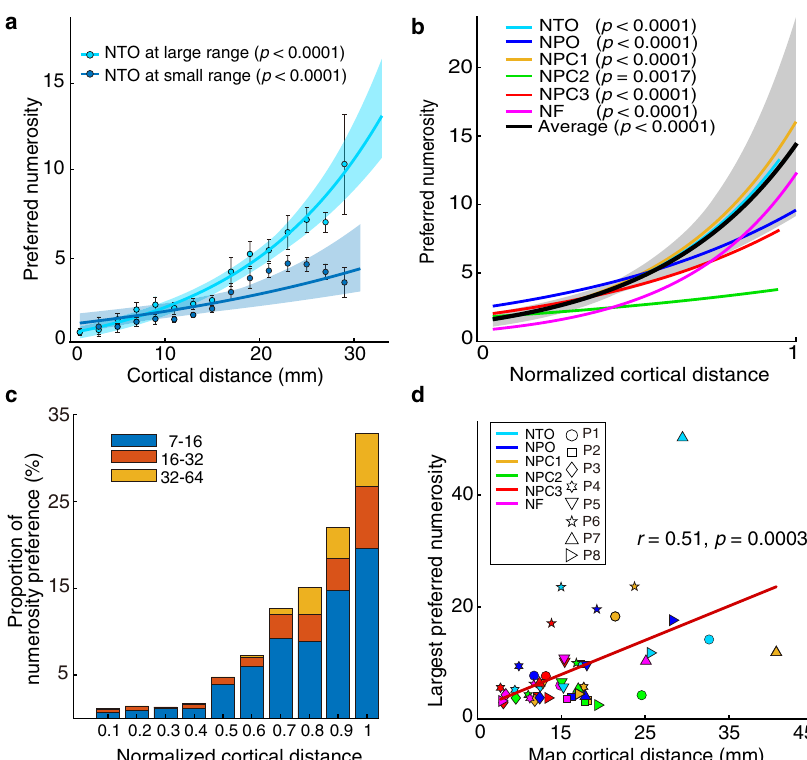
Fig. 3 Visualization of the large numerosity preference locations. a Cortical progression of small (dark blue) and large (light blue) preferred numerosities with the cortical distance (between the white lines in Fig. 1a & b) across participant 1 ’ s NTO map. The preferred numerosity increased systematically for both conditions. Points represent the mean preferred numerosity in each distance bin (every 2 mm); error bars showing standard errors of the mean over data points within each bin. Coloured lines show the best logarithmic fi ts. b Progression of numerosity preferences estimated from the large range as a function of normalized cortical distance in all the numerosity maps of participant 1. The black line shows the best logarithmic fi t that bins the data points from all the maps across normalized cortical distance. Shade area shows the 95% con fi dence interval determined by bootstrapping fi ts ( n = 1000) to the binned points and p values indicate the probability of the observed change from permutation analysis ( n = 10,000), in both ( a ) and ( b ). c Proportion of tuned responses to large preferred numerosities (above 7) for each 10% interval of normalized cortical distance in all maps of all participants. Coloured bars represent the proportion of preferred numerosities ranging from 7 to 16, 16 to 32, and 32 to 64. d Map size (cortical distance) correlates with the largest preferred numerosities in the maps, i.e., large maps typically contain larger numerosity preferences. Source data are provided as a source data fi